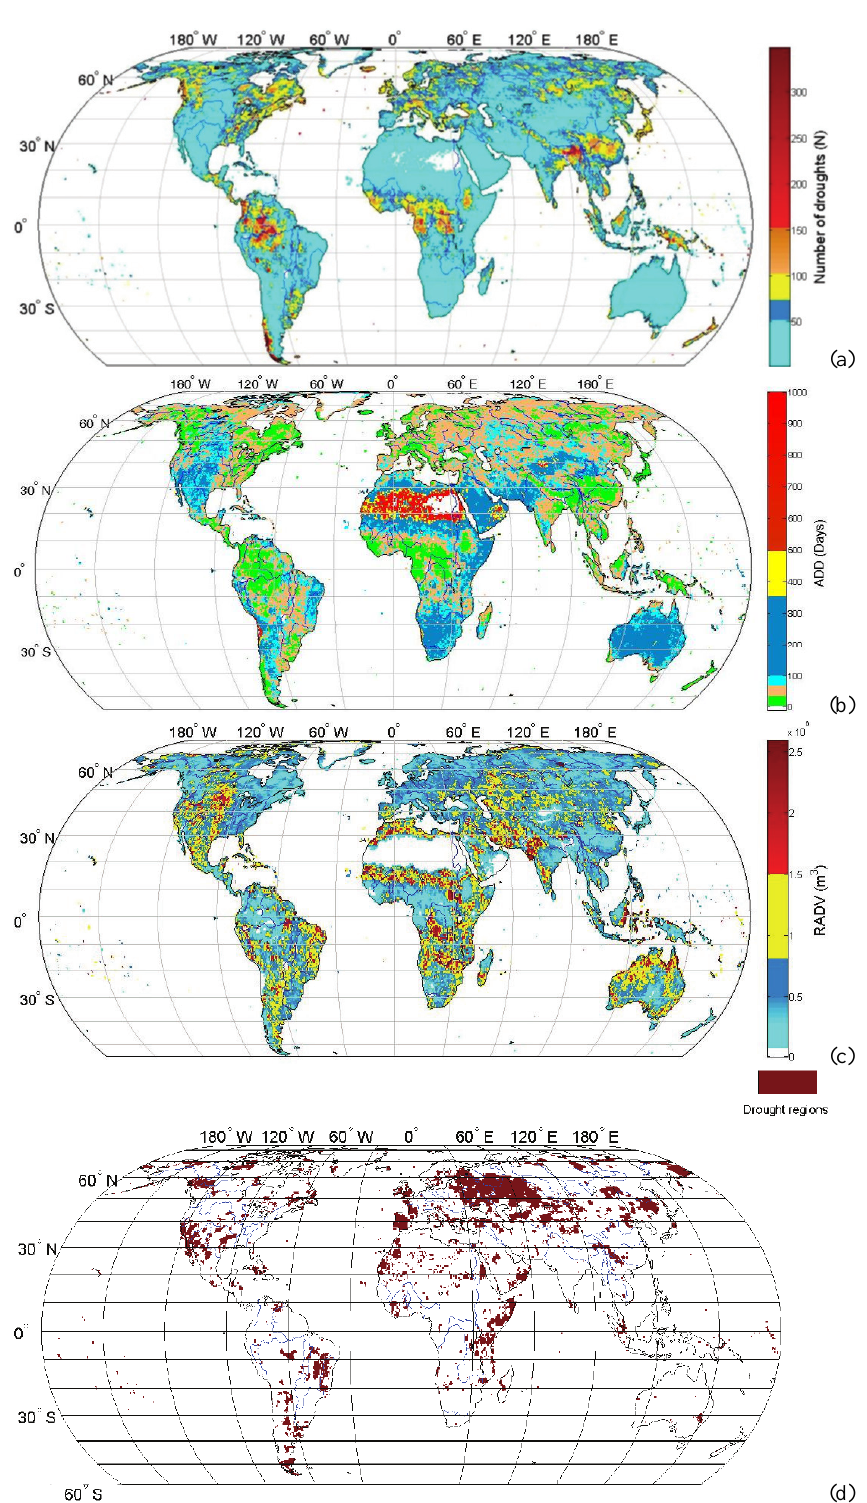
Fig. 6. Hydrological drought characteristics derived from the subsurface runoff simulated with the WaterGAP model. (a) Total number of drought events, (b) average drought duration, (c) relative average deficit volume and (d) spatial distribution of drought events for 13 Jan- uary